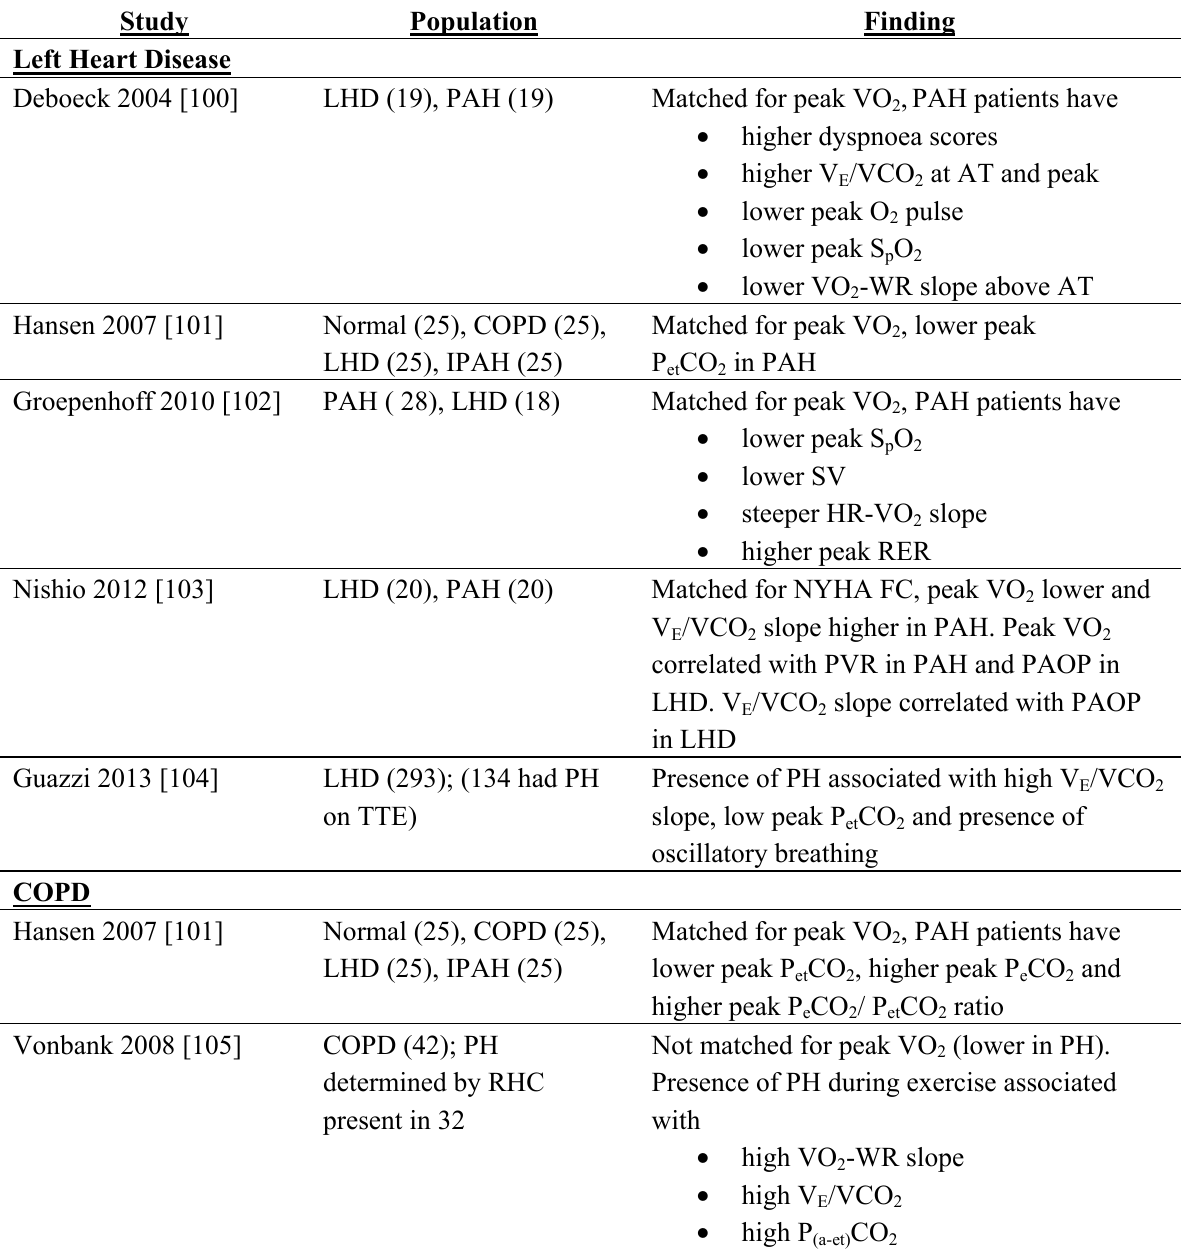
Table 1. Studies comparing cardiopulmonary exercise test (CPET) variable responses in PAH with left heart, hypoxic lung and chronic thromboembolic disease or in these conditions complicated by